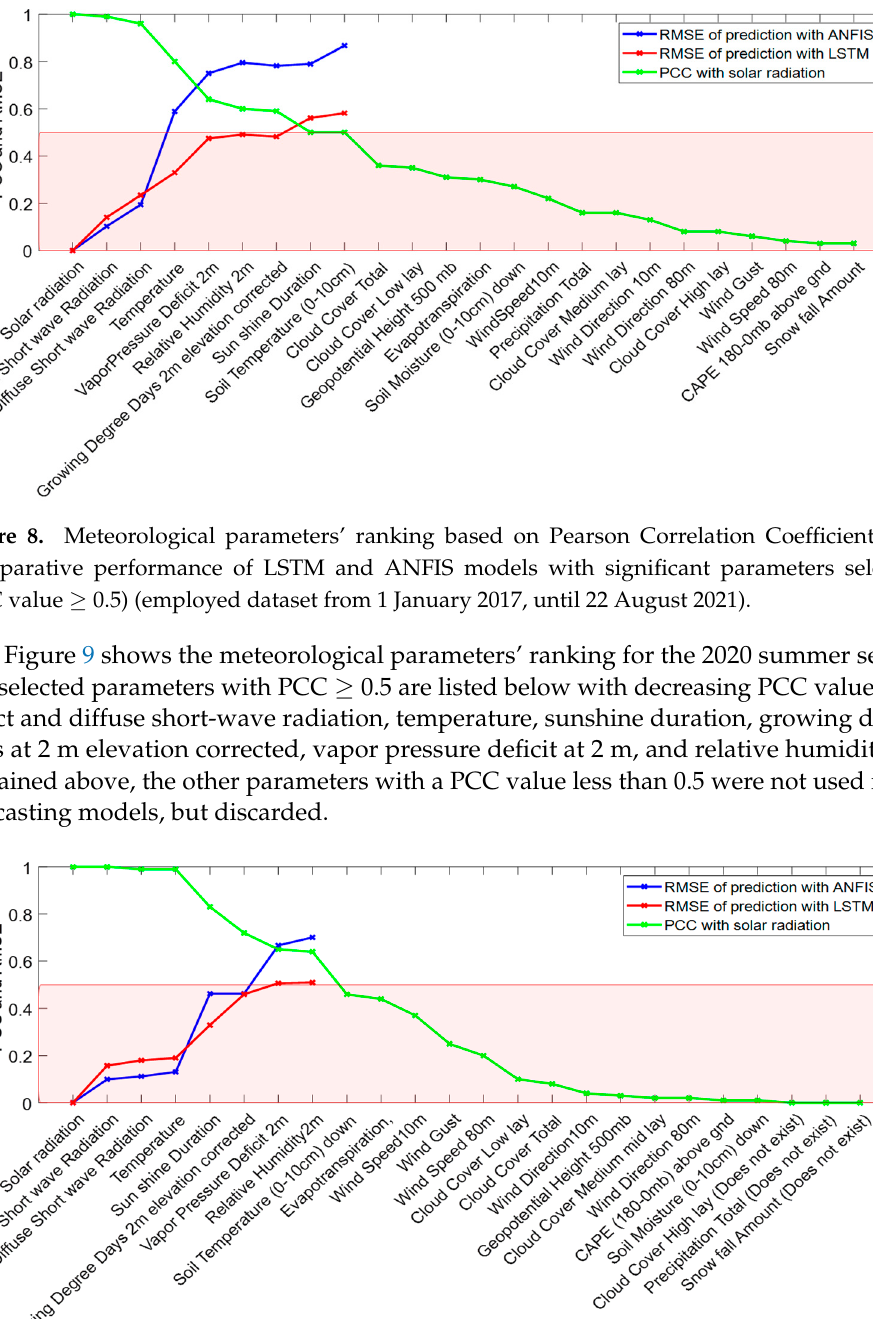
Figure 9. Summer season ranking between the different meteorological parameters based on Pearson Correlation Coefficients and comparative performance of LSTM and ANFIS models with significant parameters selection (PCC ≥ 0.5) (dataset from 21 June 2020 to 20 September 2020).